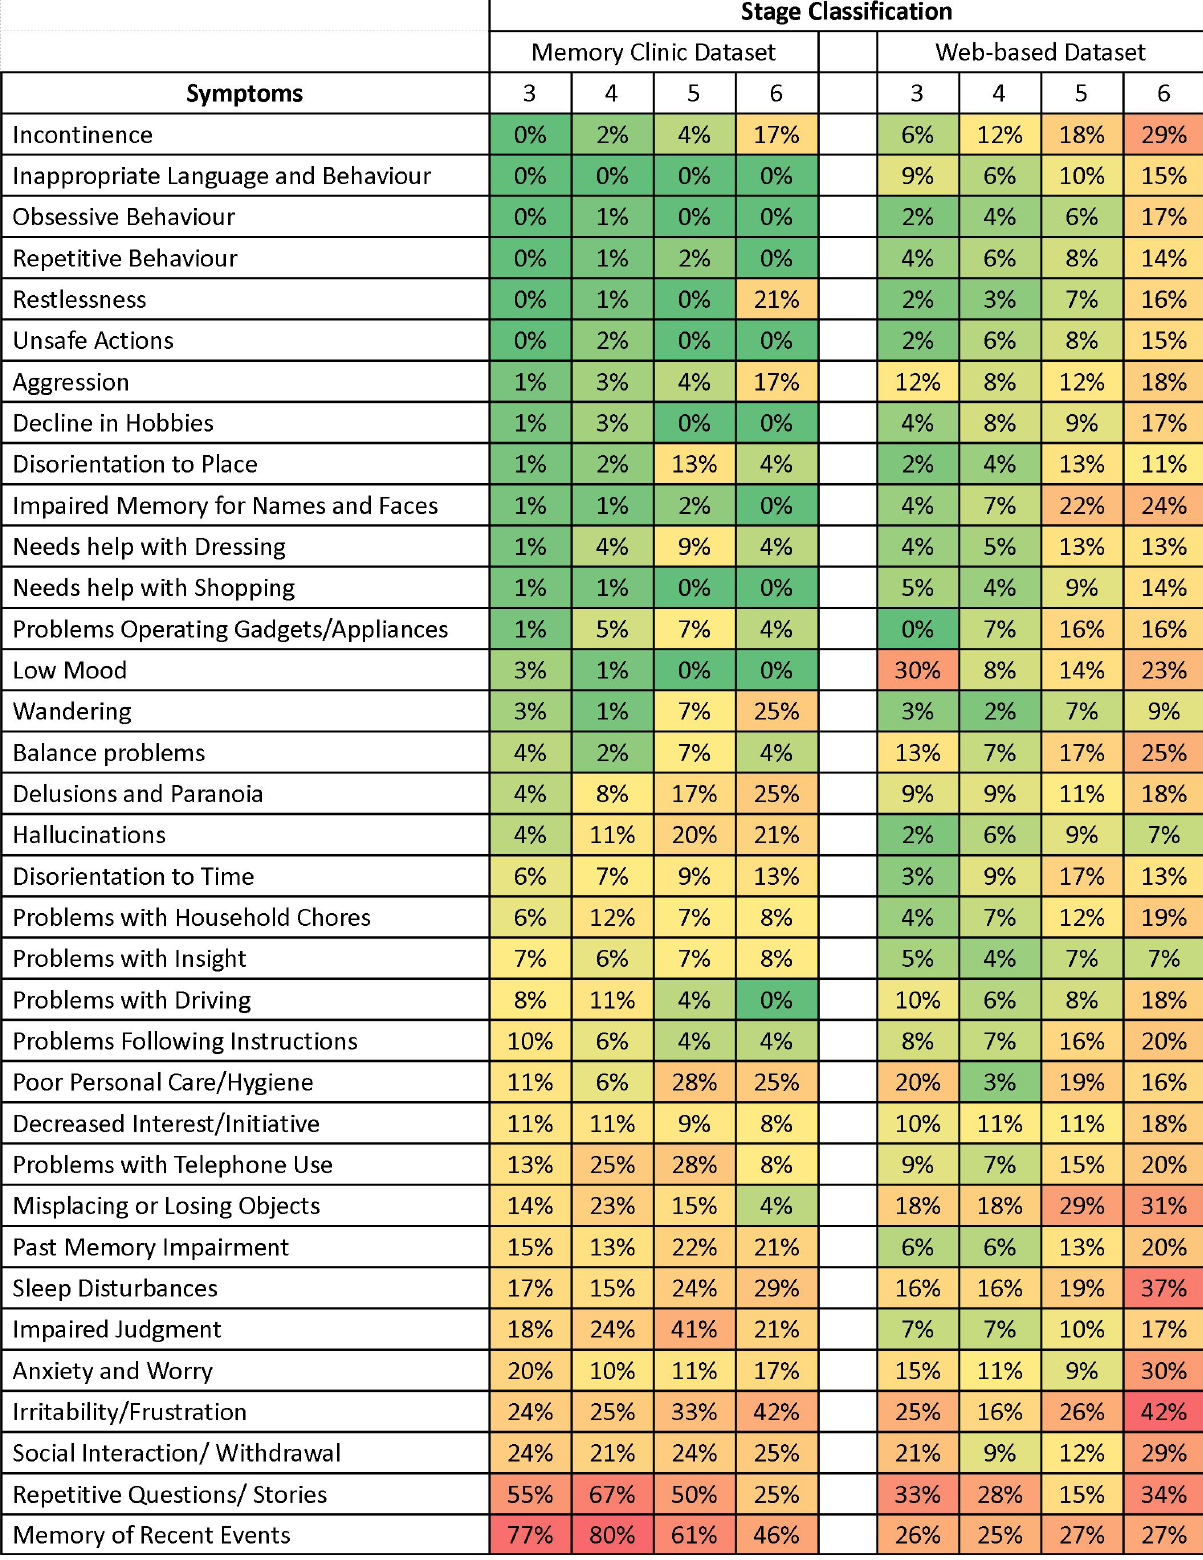
Figure 3. Comparison of the distribution of symptoms between the Memory Clinic and Web-users. Colour represents symptom frequencies: green (lower frequencies) to yellow (intermediate) to red (higher